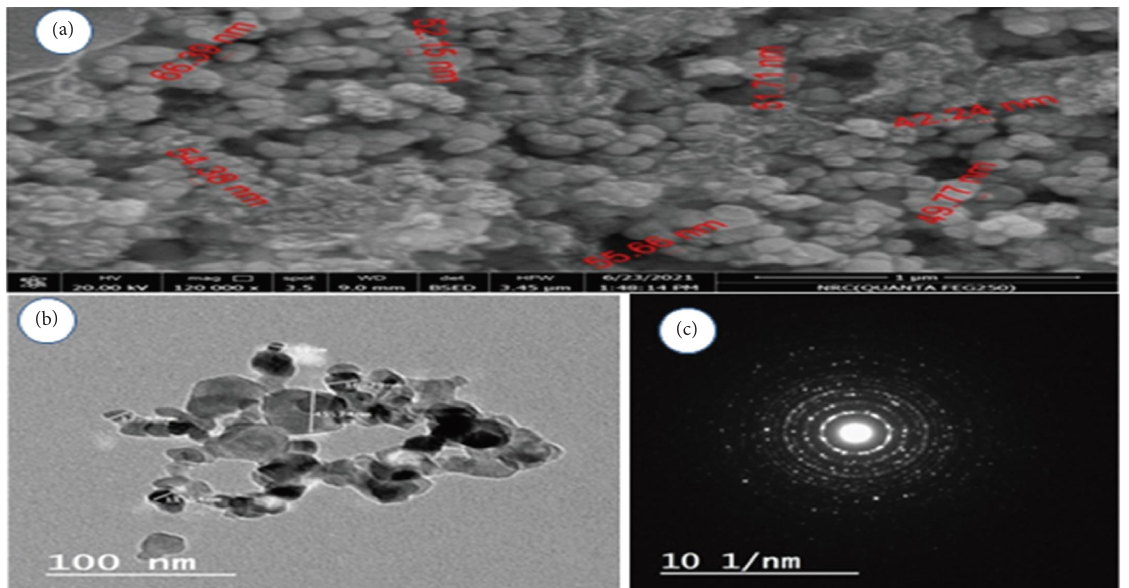
Figure 3: (a) Micrographs of A. herb Alba TiO2 NPs using SEM showed crystalline rods and relatively spherical shapes of the green synthesized NPs, with an average size of 42–66 nm. (b) TEM images of TiO2 NPs synthesized with A. herb Alba TiO2 NP aqueous leaf extract. (c) Selected area electron difraction (SAED) pattern transmission electron microscopy is the most frequently reported technique to analyze the structure, size, and shape of the synthesized NPs.